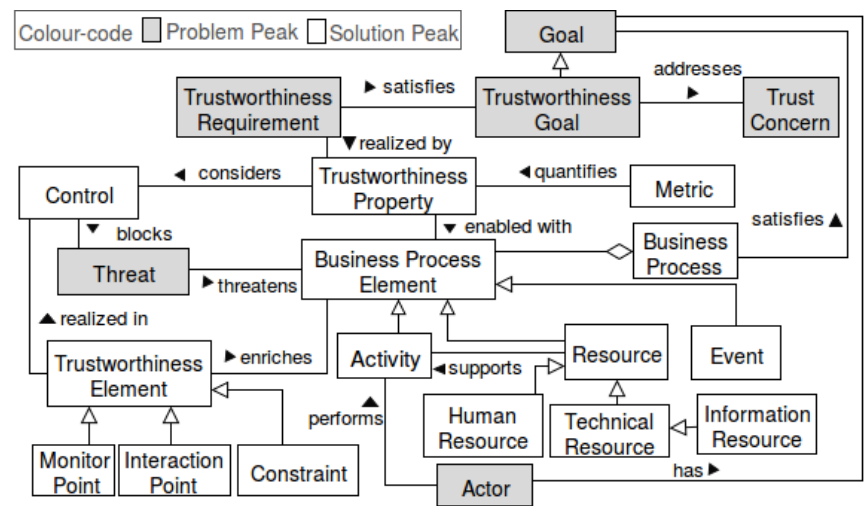
Figure 3. Conceptual model of our proposed framework and the